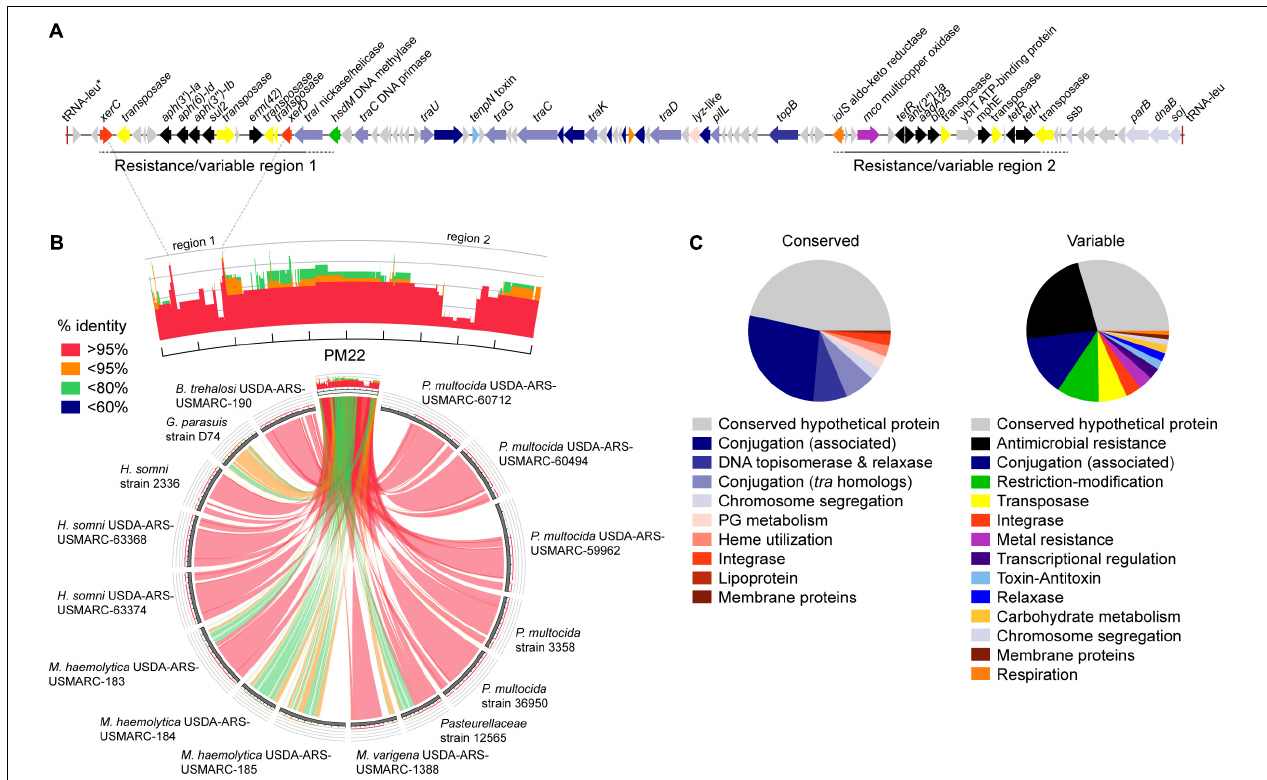
FIGURE 1 | Genomic characterization of the ICE Mh1 -like variant ICE Mh1 PM22 . (A) Gene schematic of ICE Mh1 PM22 with genes shown as arrows and colored by functional characteristics, as shown in panel (C) . (B) Comparison of ICE Mh1 PM22 with selected Pasteurellaceae genomic ICE sequences. In some cases, the ICE region cannot be delimited by the identification of the flanking direct repeat and includes sequences likely external to the ICE. Histograms represent the frequency and sequence identity (color) of alignments to ICE Mh1 PM22 : red, > 95% sequence identity; orange, > 95%; green, < 80%; blue, < 60%. (C) Frequencies of annotated genes by functional characteristics found in conserved (left) and variable (right) regions in 41 ICE Mh1 -like-containing Pasteurellaceae (with > 80% sequence identity and > 50% query coverage alignment to ICE Mh1 PM22